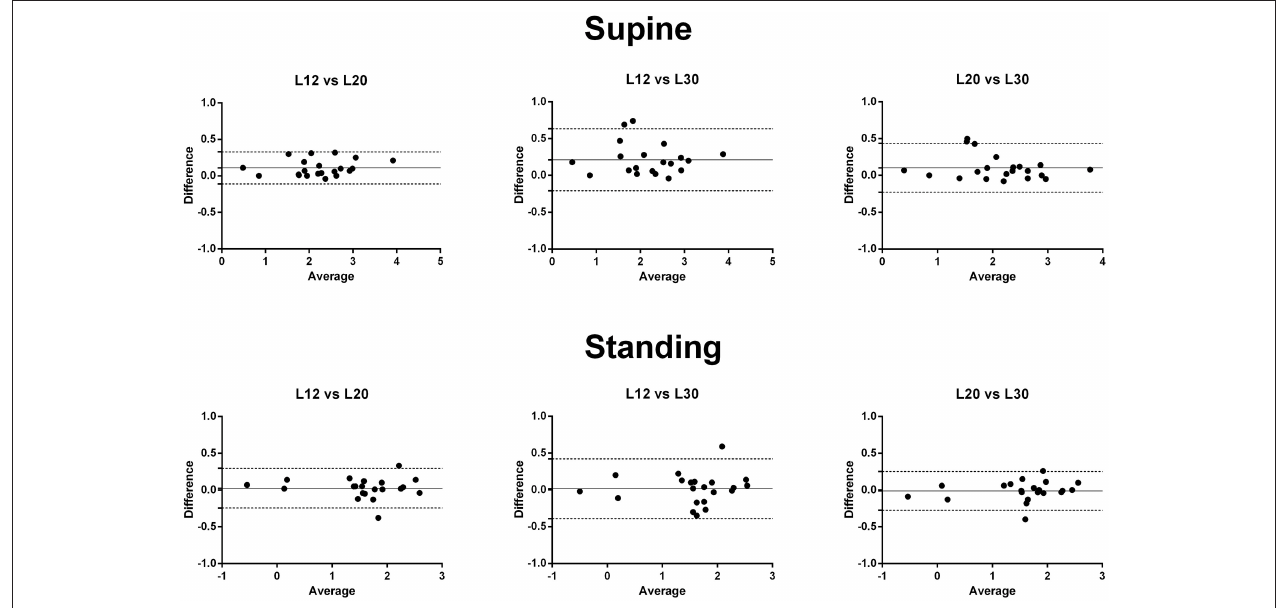
FIGURE 4 | The Bland-Altman plot of the differences and means of the logarithmic transformed BRS-values using different lengths of local data segments. BRS-values obtained using local data segments of 12s were higher than those using local data segments of 20 and 30s (fixed bias). There was no significant proportional bias. L12, BRS calculated using the local data segments of 12s; L20, BRS calculated using the local data segments of 20s; L30, BRS calculated using the local data segments of